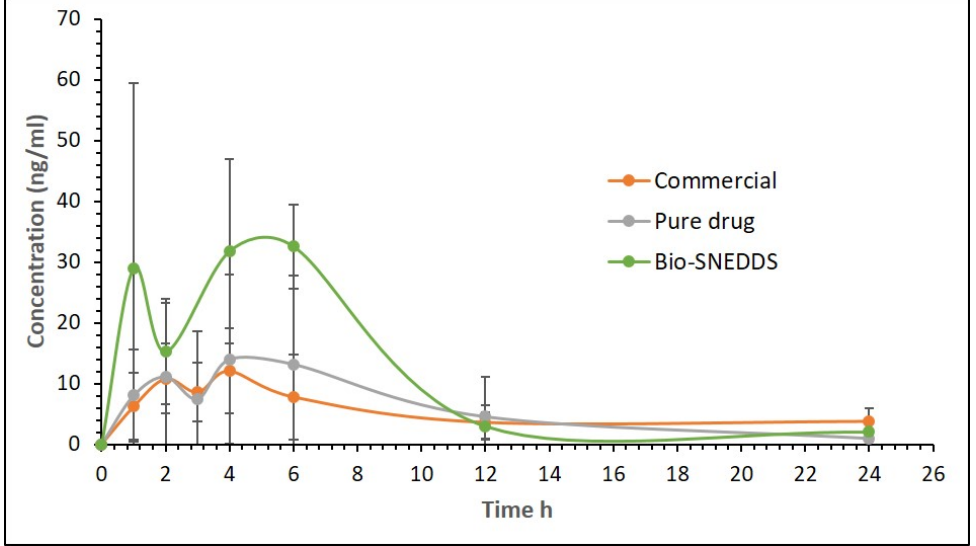
Figure 9. Plasma concentration–time profiles of APG after a single oral administration of the Bio- SNEDDS formulation [F11, CoFA:CMCM:TC (3:1:1)/HCO30 [1/1]] and APG pure powder to rats at a dose equivalent to 10 mg/kg (Mean ± SD, n =